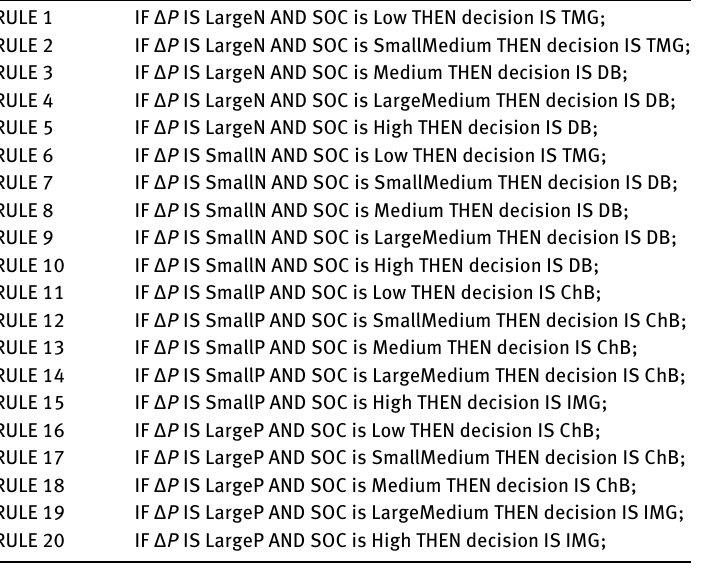
Table 2: Inference Rules Used in Fuzzy Logic